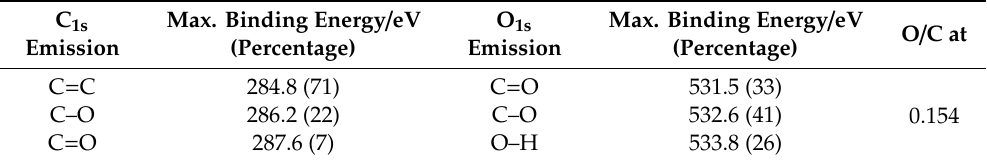
Table 1. Binding energies and percentages of di ff erent groups obtained from X-ray photoelectron spectra